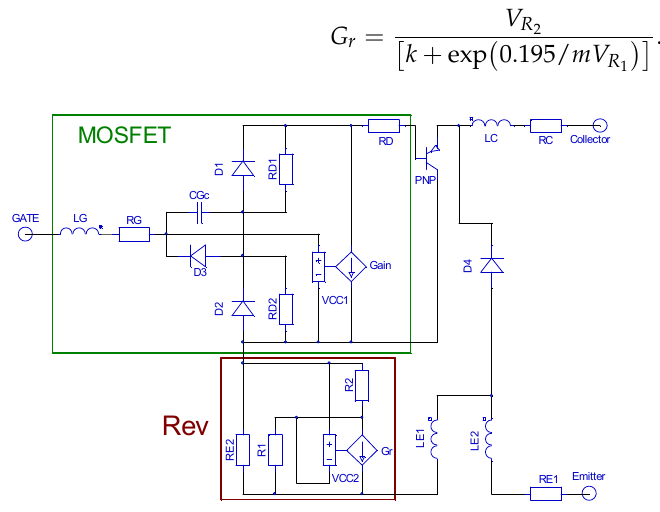
Figure 5. Equivalent circuit model of the IGBT.